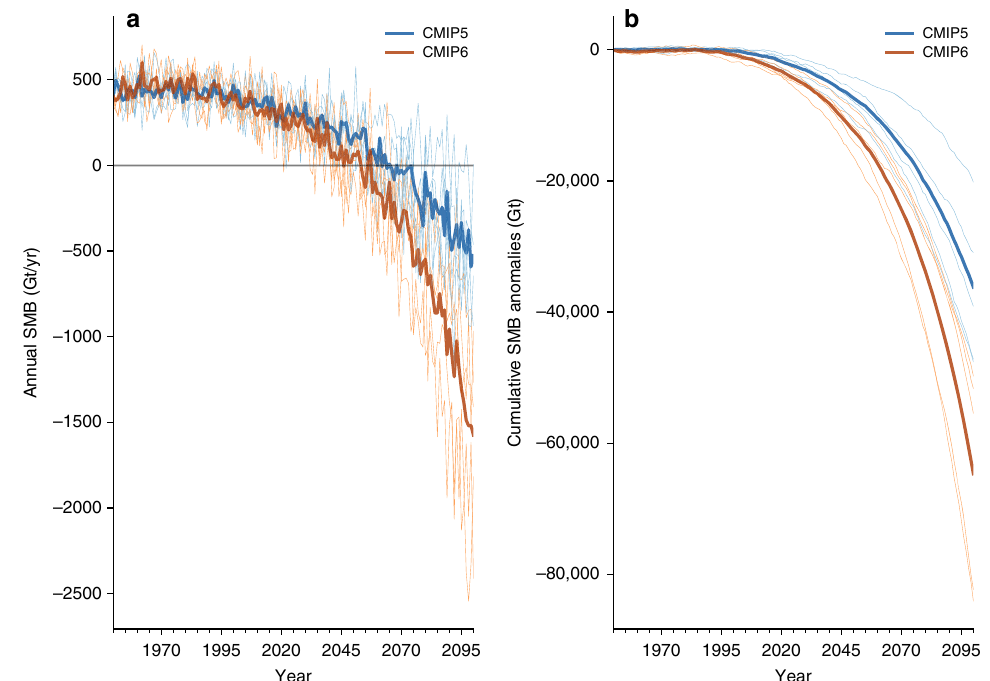
Fig. 3 Greenland surface mass balance comparison between downscaled CMIP5 and CMIP6 MAR simulations. a Annual Greenland Ice Sheet wide integrated annual SMB from six CMIP5 forced MAR simulations (blue) and fi ve CMIP6 MAR simulations (orange) in Gigatonnes per year (Gt/yr). The dark blue line represents the mean of all CMIP5 MAR simulations (6, RCP8.5) and dark orange is the mean of all CMIP6 MAR simulations (5, SSP585). The individual runs are shown in lighter colors. b Same as a but for the cumulative GrIS SMB anomalies (Gt), based on the 1961 – 1990 average of the